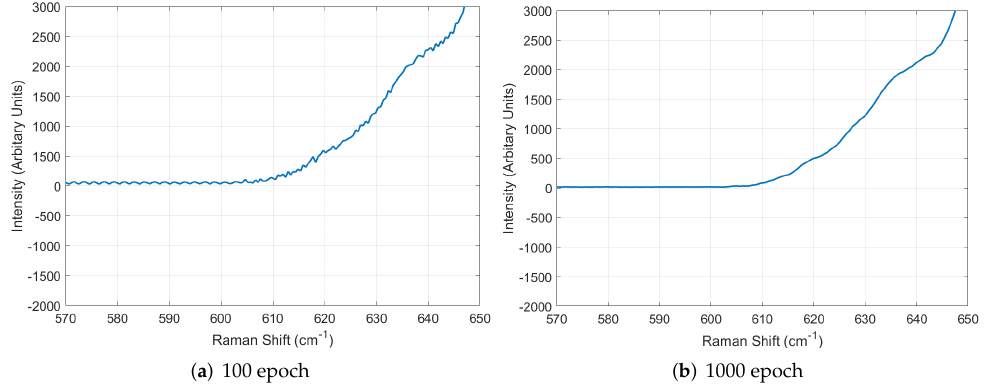
Figure 9. Performance analysis of DAE in terms of the amount of training.